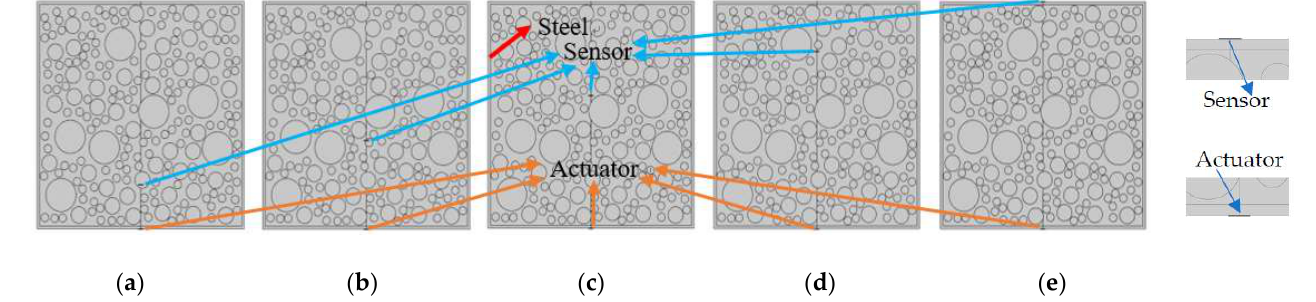
Figure 2. CMFEM 1 with PZT sensors at different measurement distances: ( a ) 80 mm; ( b ) 160 mm; ( c ) 240 mm; ( d ) 320 mm; ( e ) 410 mm. Table 1. Material parameters.